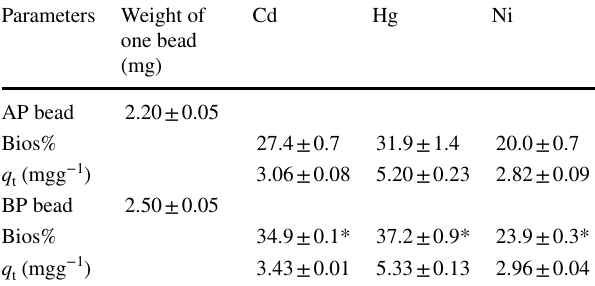
Table 6 FVP bead biosorbent concentration parameters